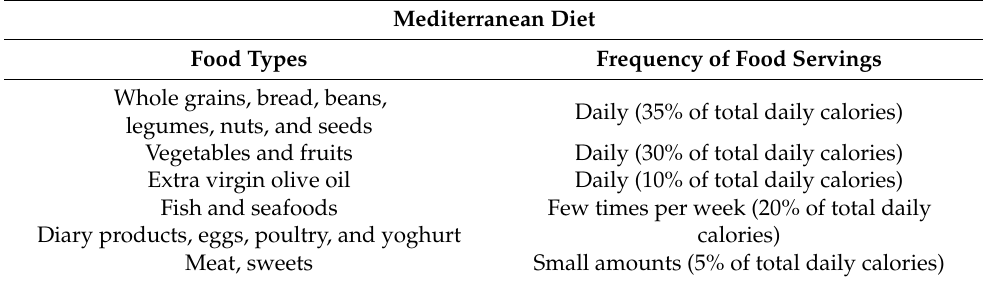
Table 3. Mediterranean diet: a guide to daily food